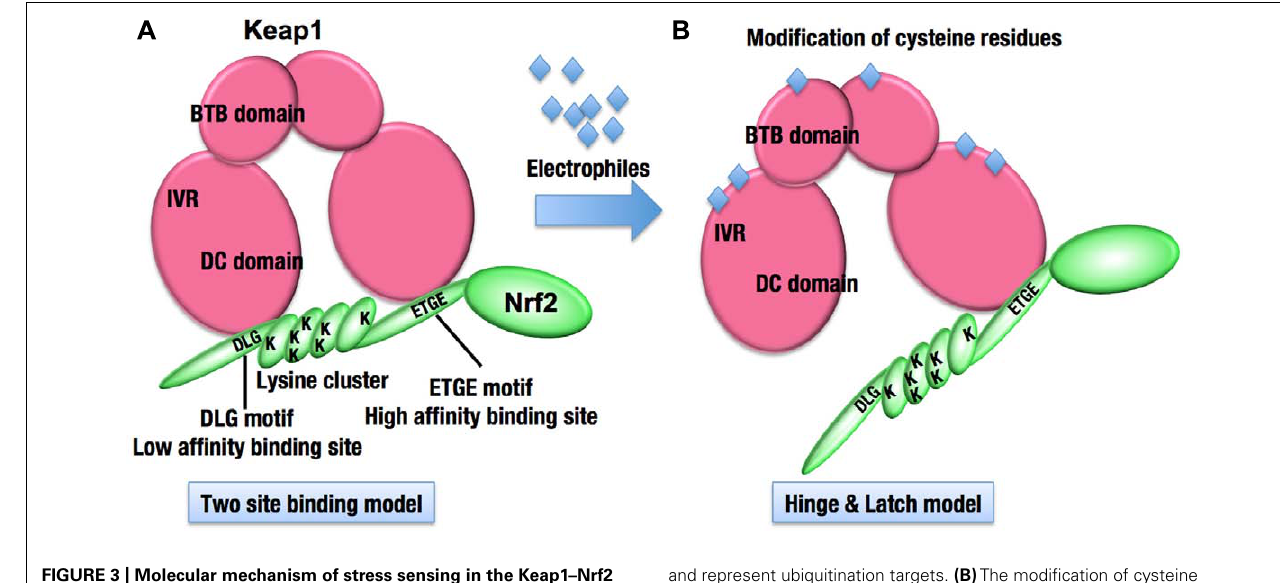
and represent ubiquitination targets. (B) The modification of cysteine residues in Keap1 with electrophiles is expected to modify the overall conformation of the Keap1 homodimer, resulting in the termination of Nrf2 ubiquitination.